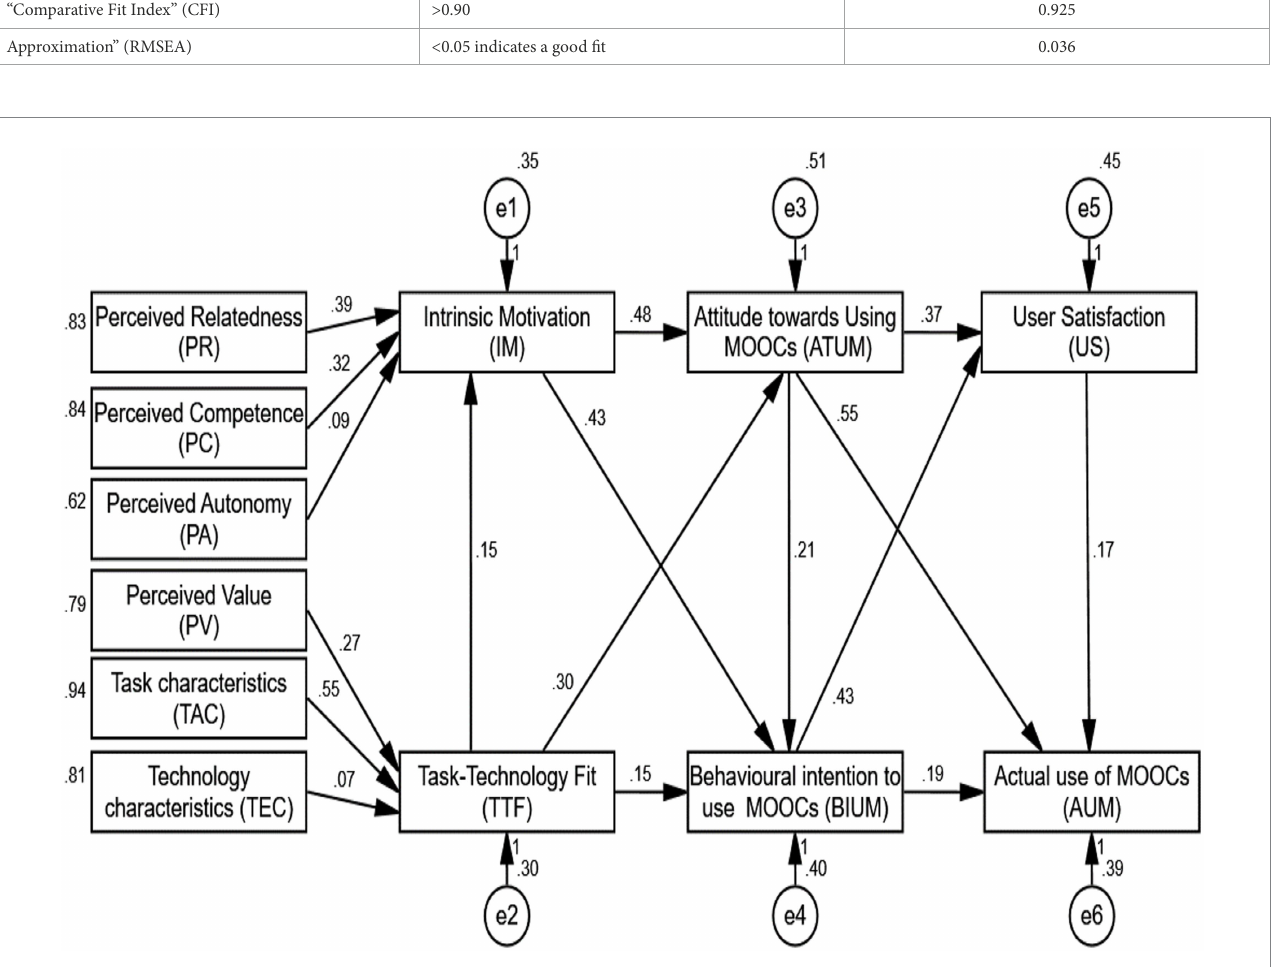
FIGURE 4 Results for the proposed